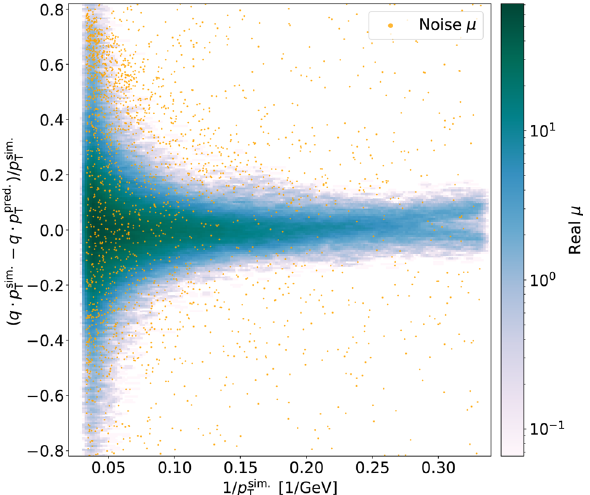
Fig. 7 Relative differences between predicted and true muon q · p T plottedasafunctionoftruesimulatedmuon1 / p T usingnetworktrained with muon candidates without noise hits. Colour coded density map shows muon candidates without any noise hits. Orange dots show muon candidates that include at least one noise